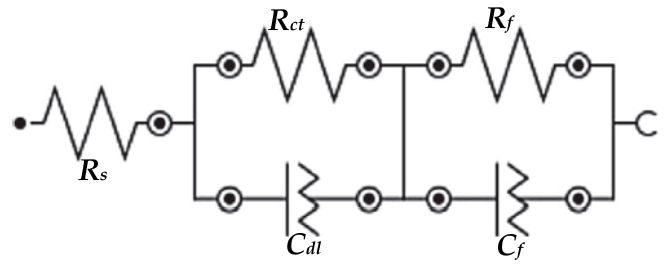
Figure 9. Equivalent circuit model (ECM) for EIS. Table 3. Electrochemical-impedance-spectroscopy (EIS) parameters for pure Al and Al-Fe alloys after one hour of immersion in 3.5% NaCl